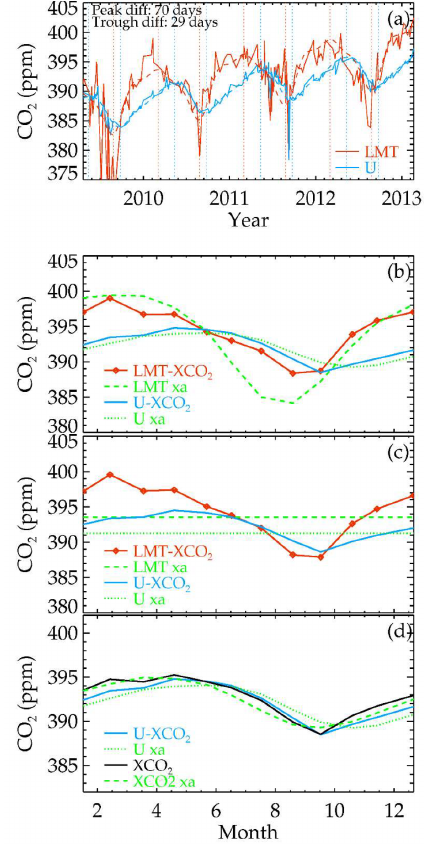
Figure 4. Simulated GOSAT retrievals from SGP aircraft profiles, Eqs. (5)–(6), and the GOSAT averaging kernels. (a) Time series of LMT (red) and U (blue) with monthly averages of LMT (red dashed) and U (blue dashed); (b) seasonal cycle, averaging in 1- month increments. Green dotted and dashed lines are the initial guess or a priori (xa). (c) Same as (b) except that the prior is set to a constant, showing that LMT and U results are not strongly in- fluenced by the prior. (d) Same as (b) but showing U (blue) and X CO 2